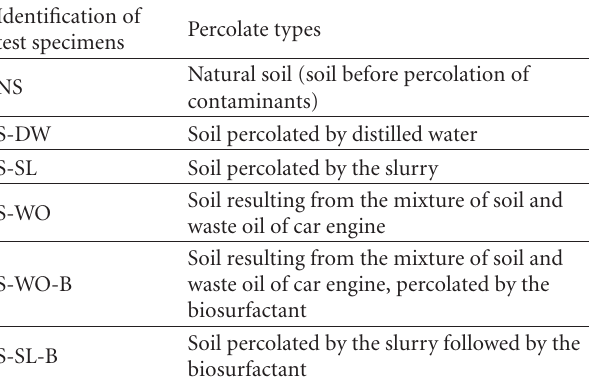
Table 1: Test specimens and percolates used in the experiments.